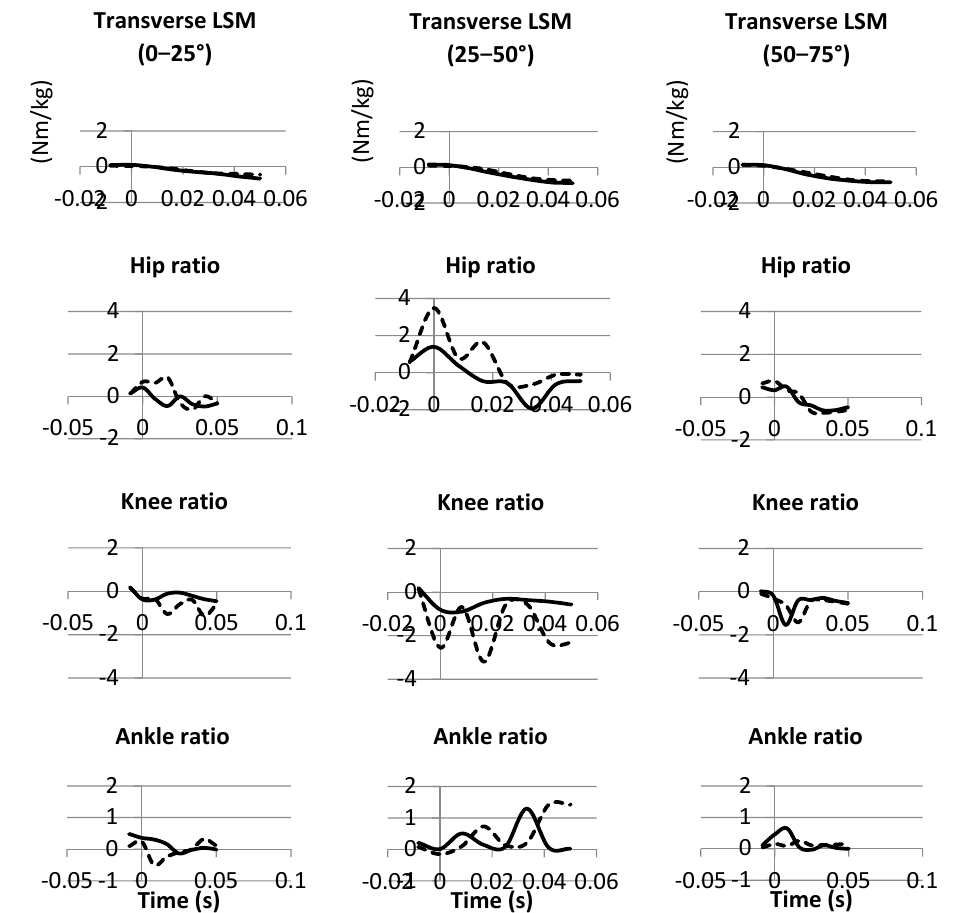
Figure 4. Transverse plane limb support moment sex comparisons with contribution ratios for each landing condition, male solid line female dashed line. LSM at top: Transverse LSM = MH + MA − MK. Moment ratios at each joint are expressed relative to the LSM as contributing (+) or not contributing ( − ) to limb support. Initial contact is 0 s.